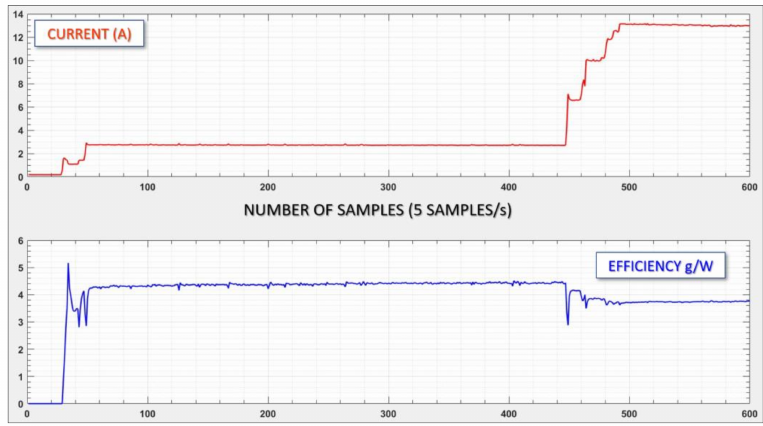
Figure 22. Current and efficiency of a propulsion set (motor-propeller) for